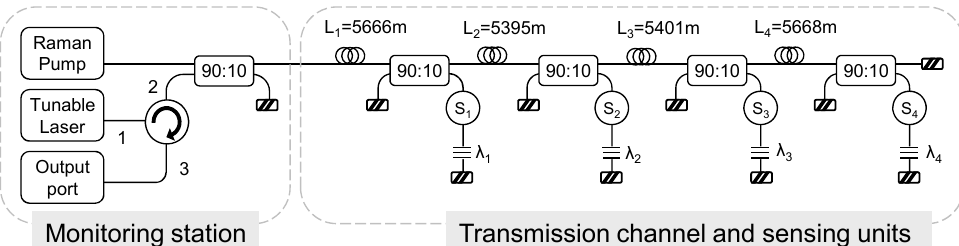
Figure 1. Wavelength-division-multiplexed distributed fiber Raman amplifier bus network. Adapted from